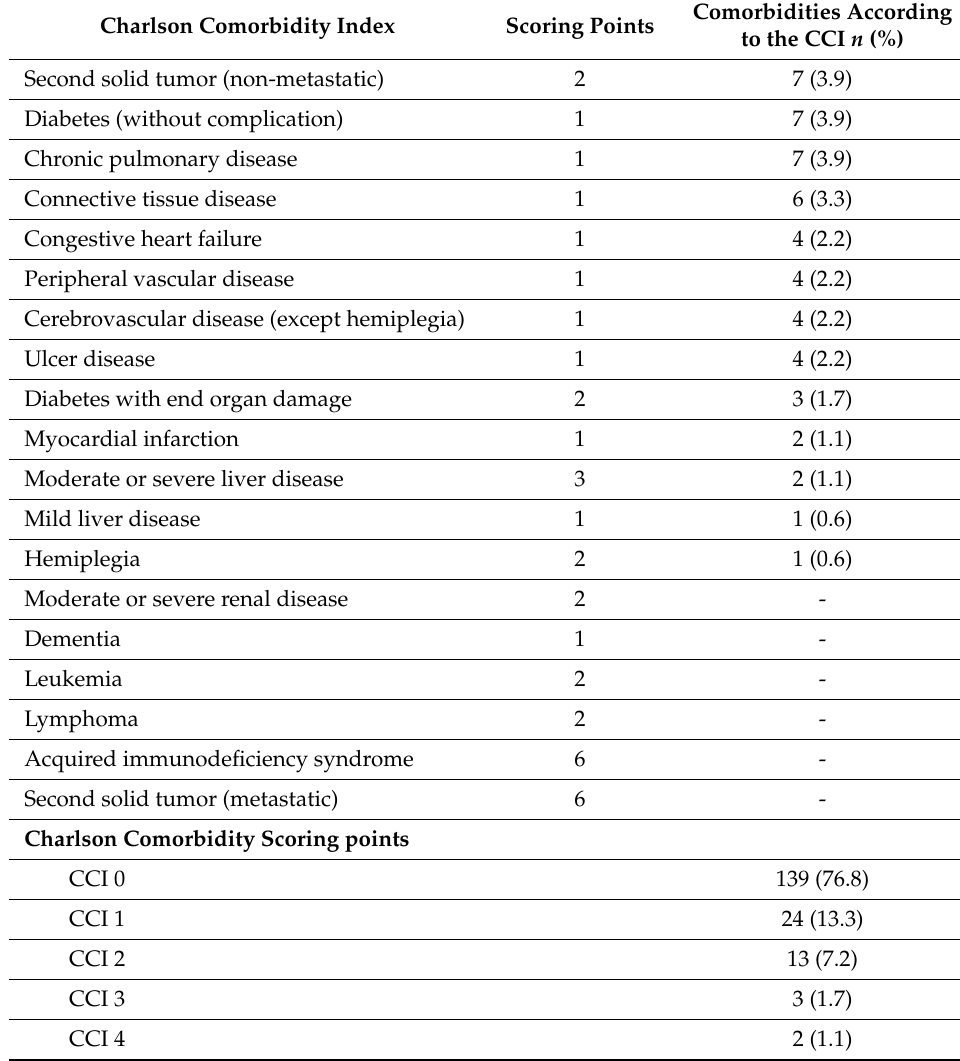
Table 2. Comorbidities as defined by the Charlson Comorbidity Index